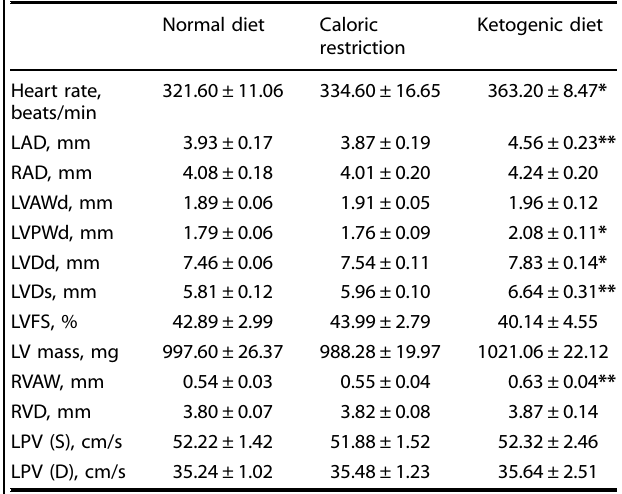
Values are mean ±SEM ( n = 6) LAD left atrial diameter, RAD right atrial diameter, LVAWd left ventricular anterior wall thickness, LVPWd left ventricular posterior wall thickness, LVDd left ventricular dimension in diastole, LVDs left ventricular dimension in systole, LVFS left ventricular fractional shortening, RVAW right ventricular anterior wall thickness, RVD right ventricular dimension, LPV left pulmonary venous fl ow, S Systolic, D diastolic * p <0.05, ** p < 0.01 versus the normal diet-fed group according